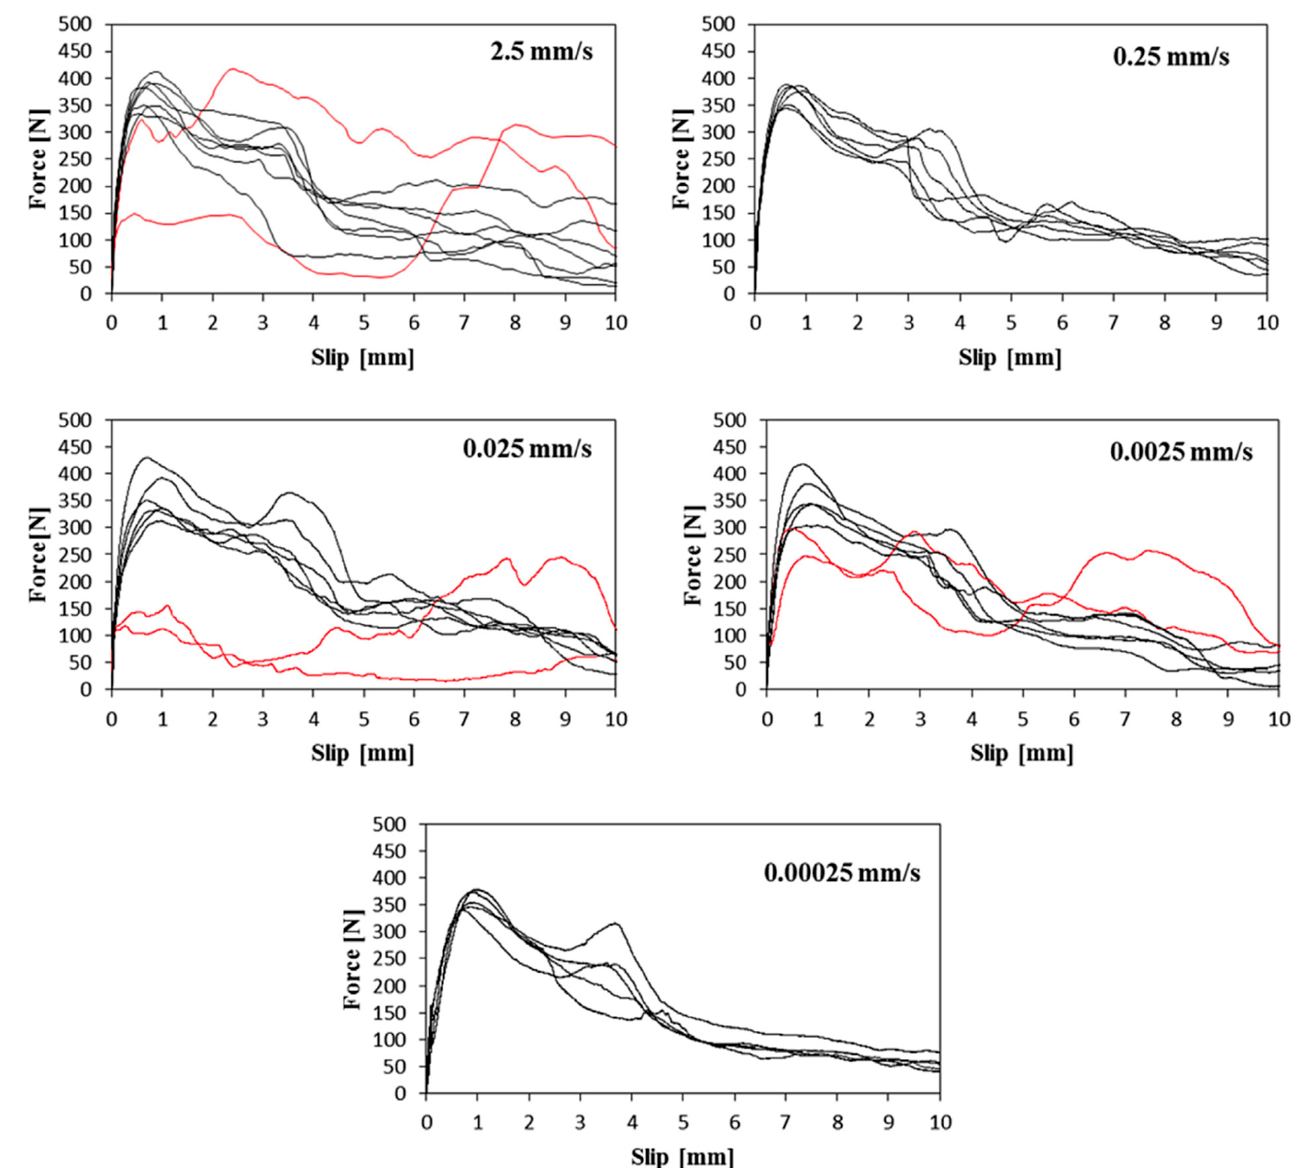
Figure 16. The single fibre pull-out test results on hooked-end fibres [101]. Tai and El-Tawil [26] have used an MTS high-rate servo-hydraulic testing system with an MTS Flex SE controller to perform single fibre pull-out experiments with different testing setups, as shown in Figure 17. A specially designed grip was used to hold the fibre connected to a force connection on the testing device. A grip was used to restrain the half dog-bone specimen used to test the regular ASTM tensile properties of concrete. In addi- tion, three different types of fibres were used: aligned straight smooth (S), hooked (H), and twisted (T). To simulate a fibre being pulled out in a standard cracked tensile sample and minimize the elongation of the fibre’s free length, the free length of the fibre was reduced throughout gripping. A laser sensor was used to calculate the slip at the reference point, defined in terms of the fibre end and matrix movement.